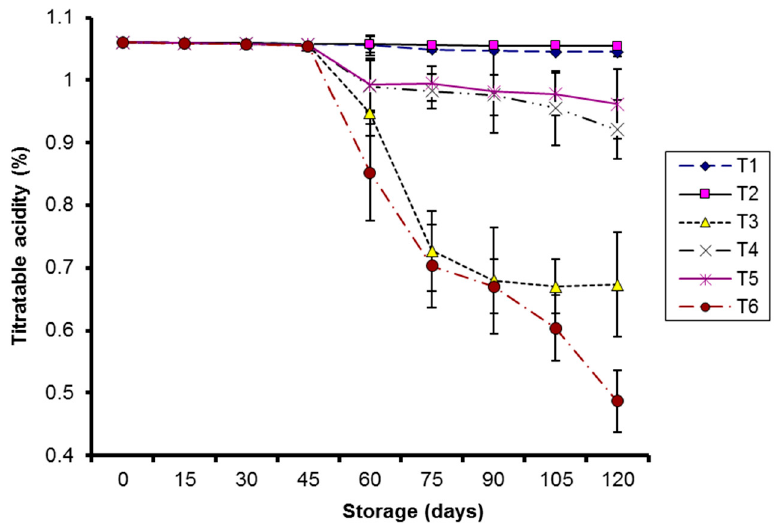
Figure 4. Effect of CMC and guargum-based silver nanoparticle coatings on the titratable acidity of kinnow fruit stored at 4 and 10 °C during storage. The vertical bars represent standard error of the means. Values represented as mean ± SE of three replicates.